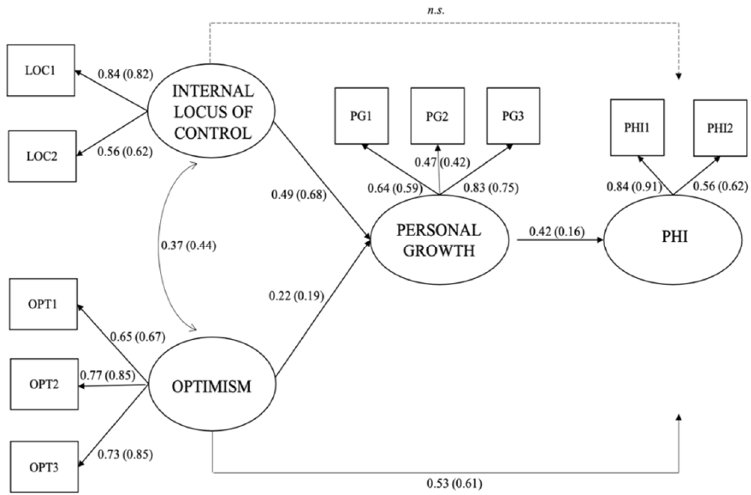
Figure 2. Results of the multi ‐ group structural equations model. Note . Group 1 = 2019—outside brackets; Group 2 = (2020)—between brackets.